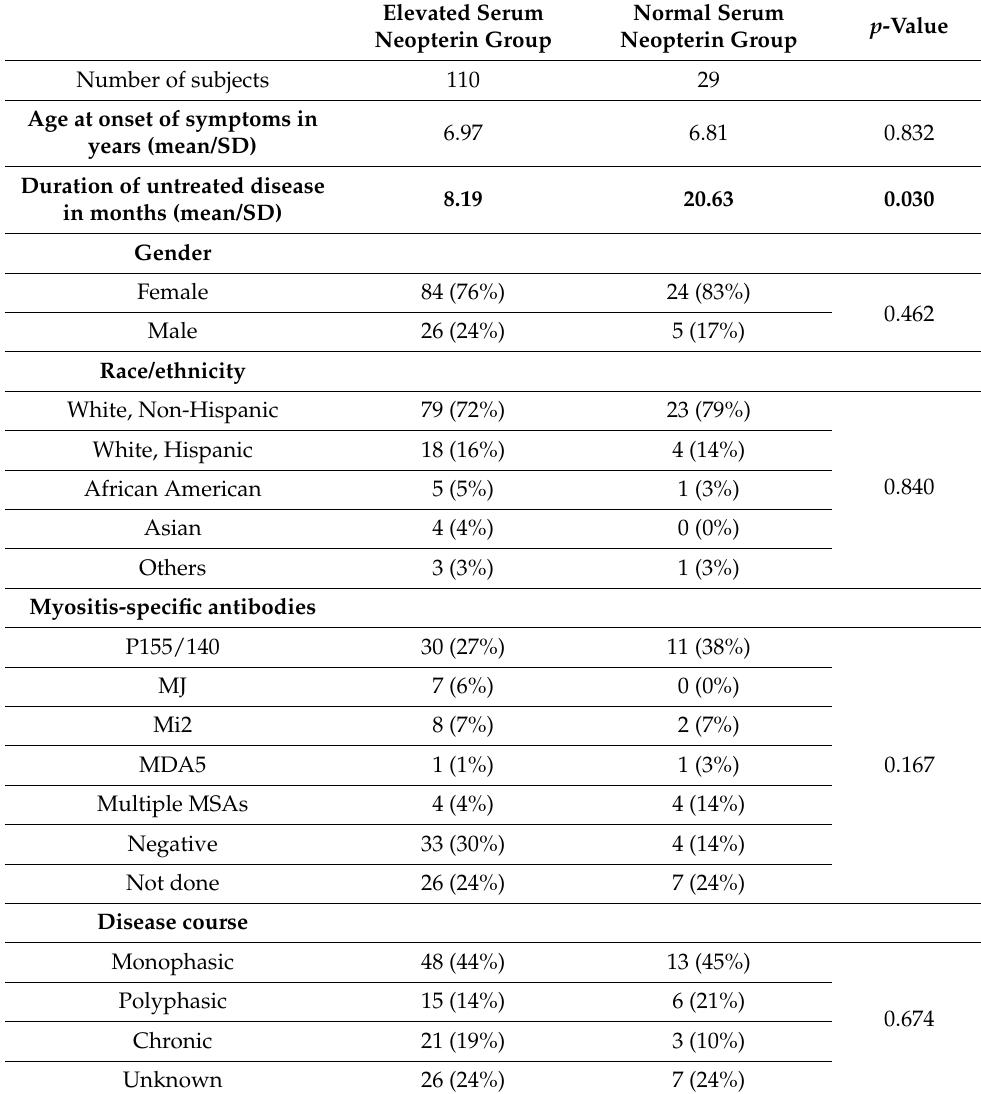
Table 1. Neopterin levels in 139 untreated children with JDM: demographic